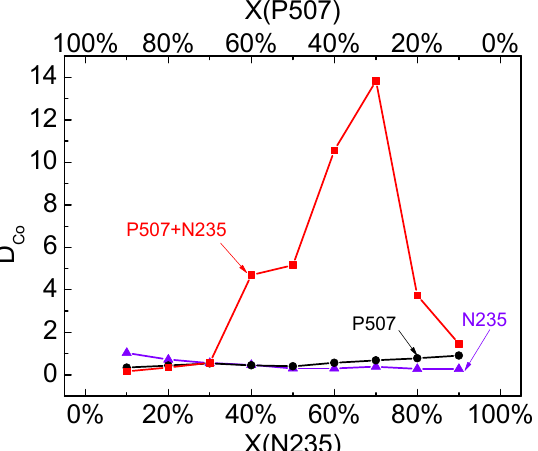
Figure 11. D Co in P507 system, N235 system, and P507–N235 system (V P507–N235 :V kerosene = 1:3, V o :V a = 4:1, pH = 2.5).